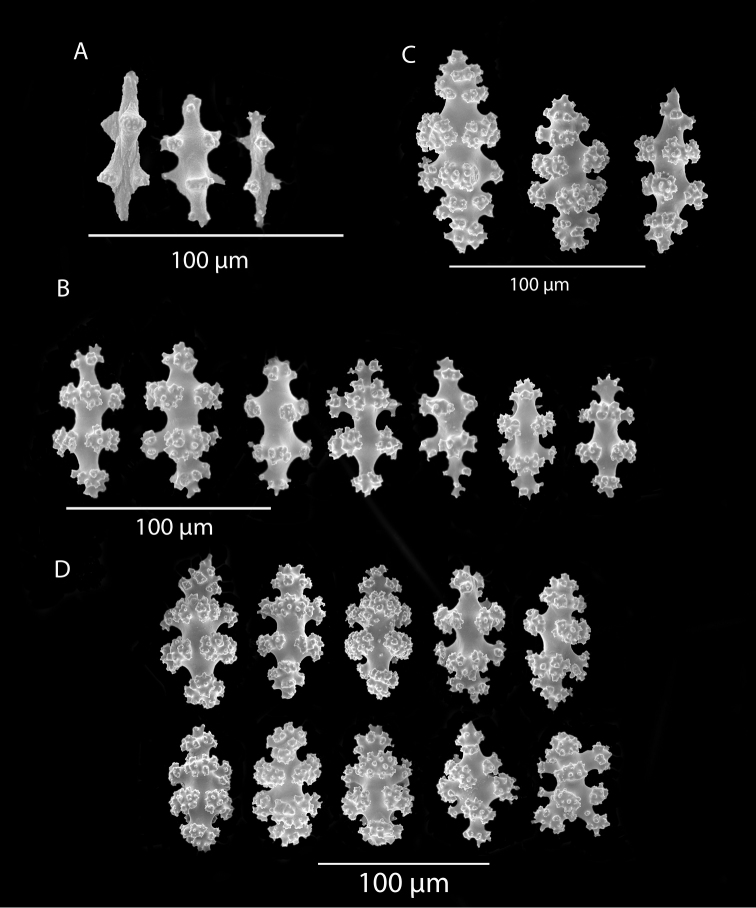
Leptogorgiachilensis, SBMNH 422953, SEM image. Color of sclerites is orange-red. A Anthocodial sclerites B–D Spindles of coenenchyme. Images closely match those shown in Breedy and Guzmán 2007 (fig. 14).